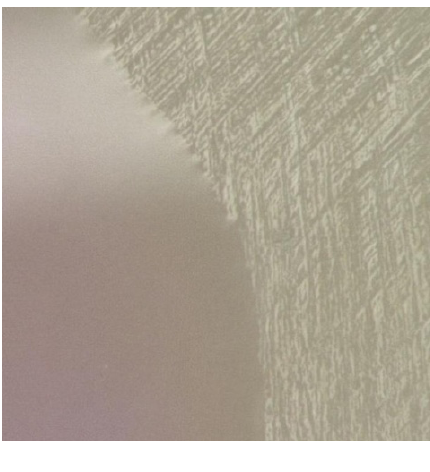
Figure 8. Enamel trimmed with a sand-paper disk ( right section ) and on which a self-etching primer has been placed ( left section ). By looking at the advancing edge of the primer, one can see a wavy appearance. That appearance can be explained by considering the behavior shown in Figure 7 and here occurring along the advancing edge. In this case, different contact angles exist at different locations along the advancing edge of the primer. Also, spreading can occur in both the x- and y-axes on a surface containing scratches and different heterogeneities in surface wetting